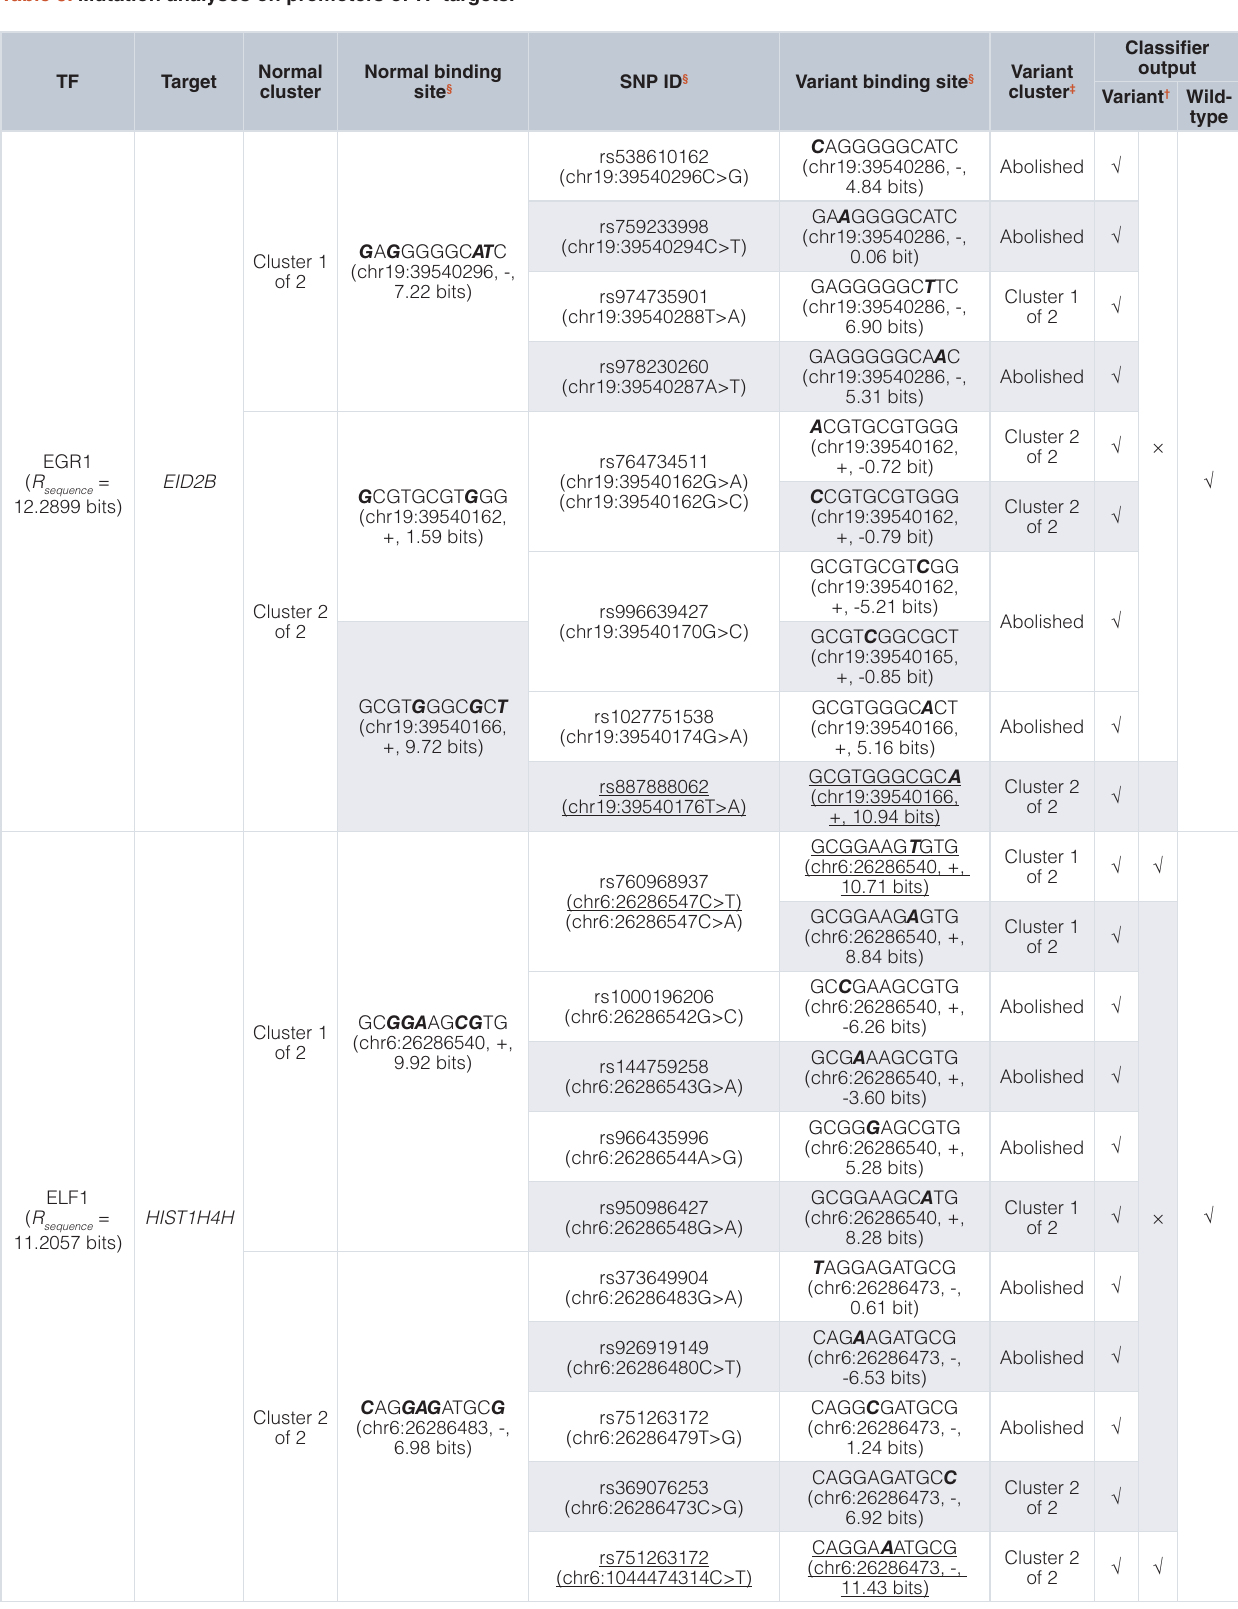
Table 5. Mutation analyses on promoters of TF